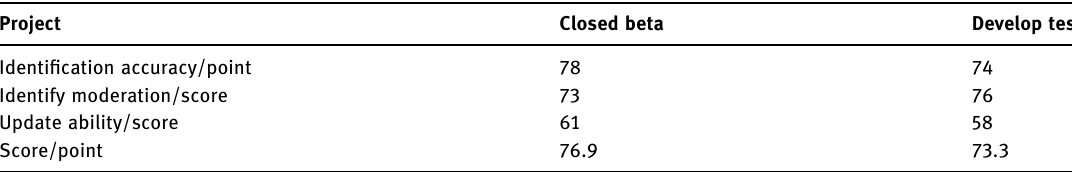
Table 2: Evaluation results of statistical algorithms